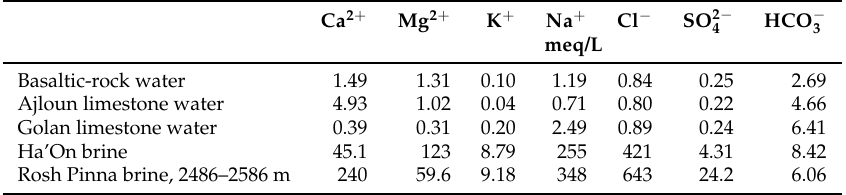
Table 2. Averages of water types in the Lower Yarmouk Gorge. For more details refer to Table A1. Ca 2 + Mg 2 + K + Na + Cl